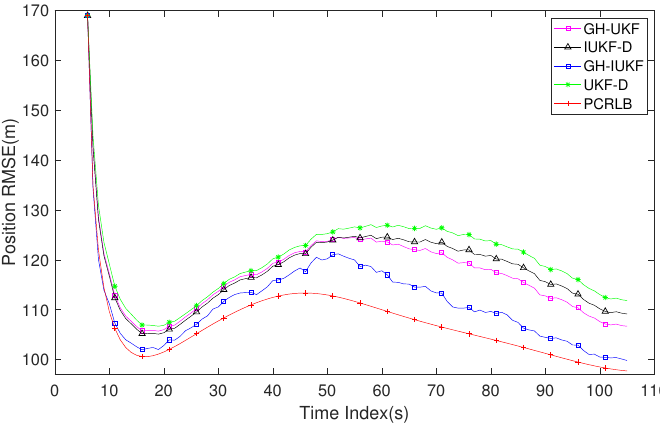
Figure 5. RMSE of the estimated position versus time index